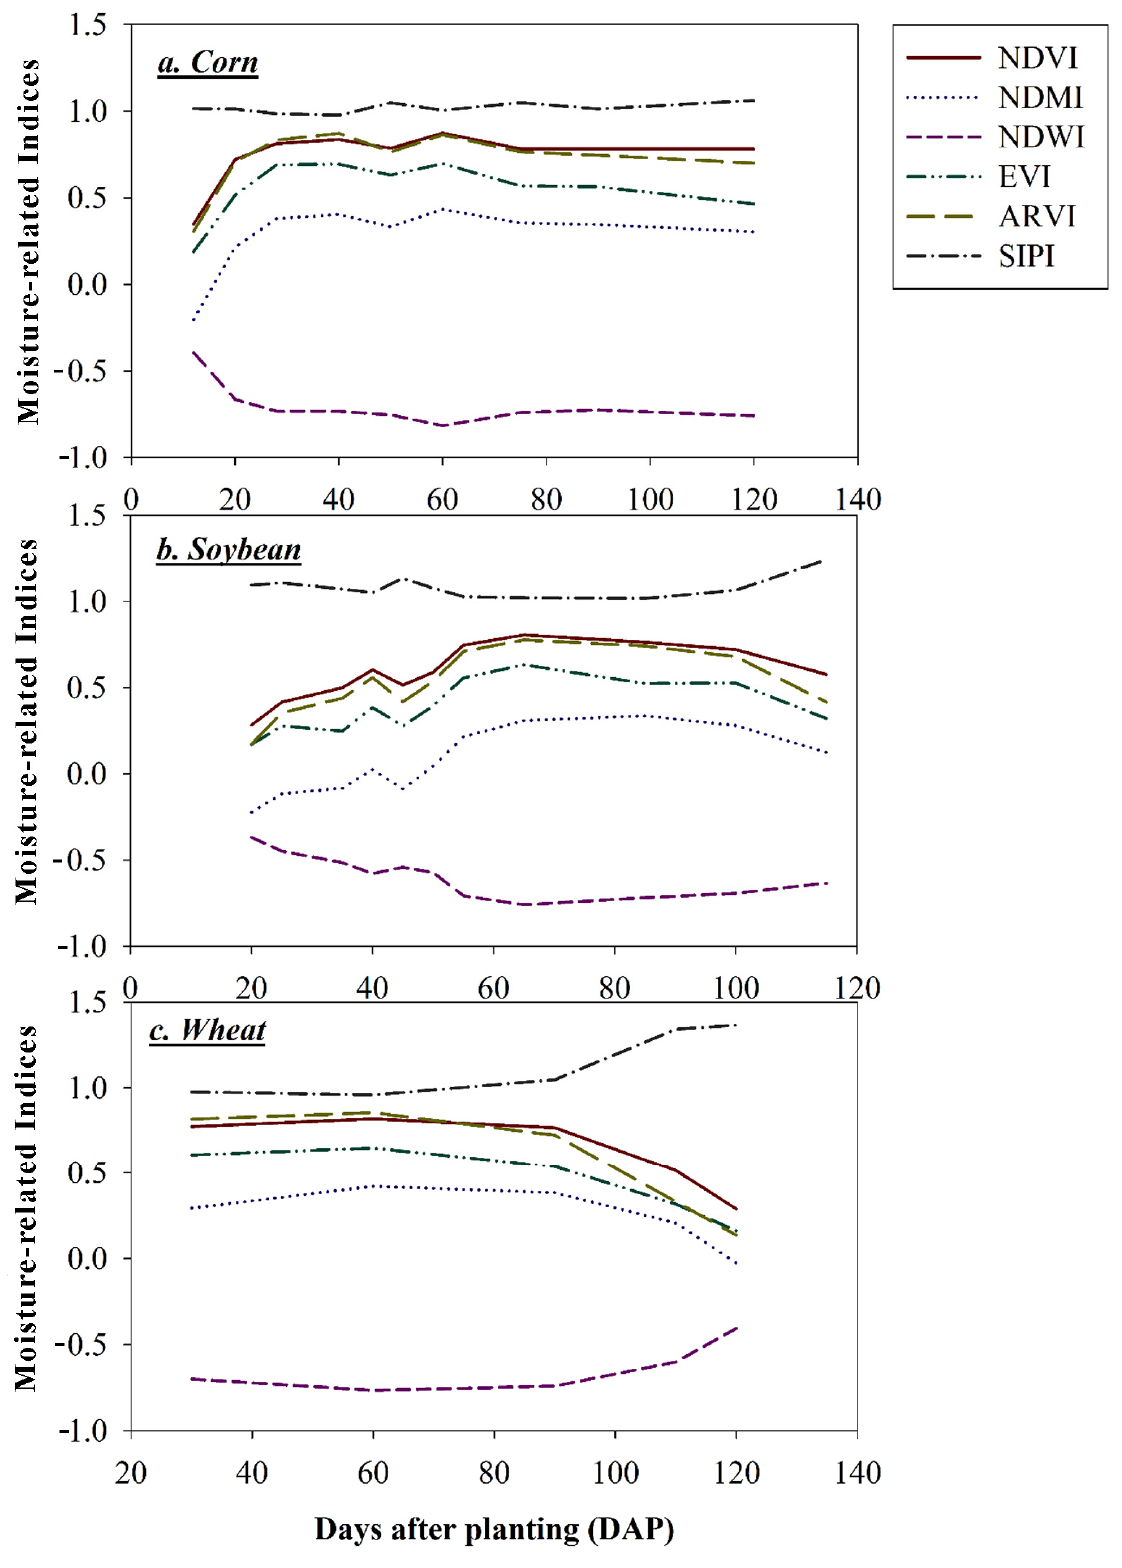
Figure 5. Changes in the values of moisture-related indices (NDVI, NDMI, NDWI, EVI, ARVI, SIPI) with the days after planting for three crops (corn, soybean, and wheat) for the 2019 growing season in the RRVN.